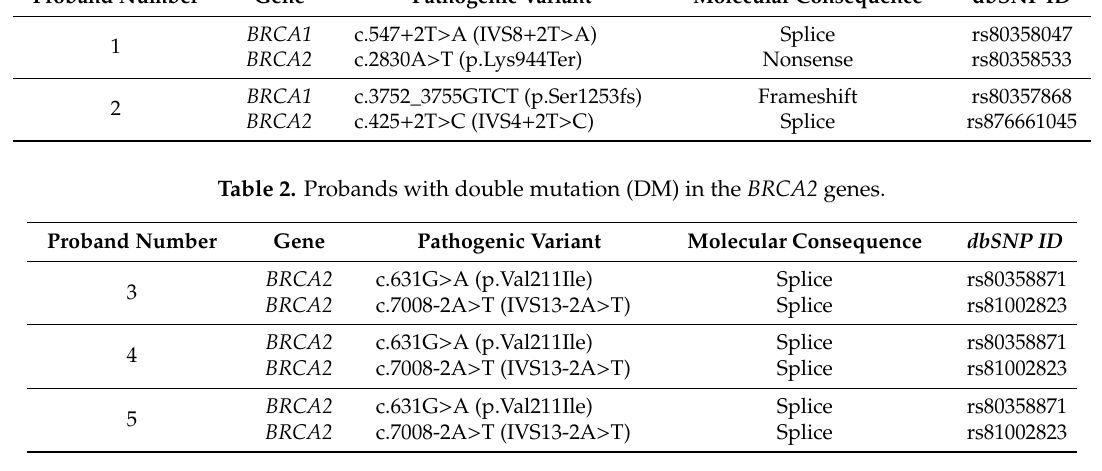
Table 2. Probands with double mutation (DM) in the BRCA2 genes.